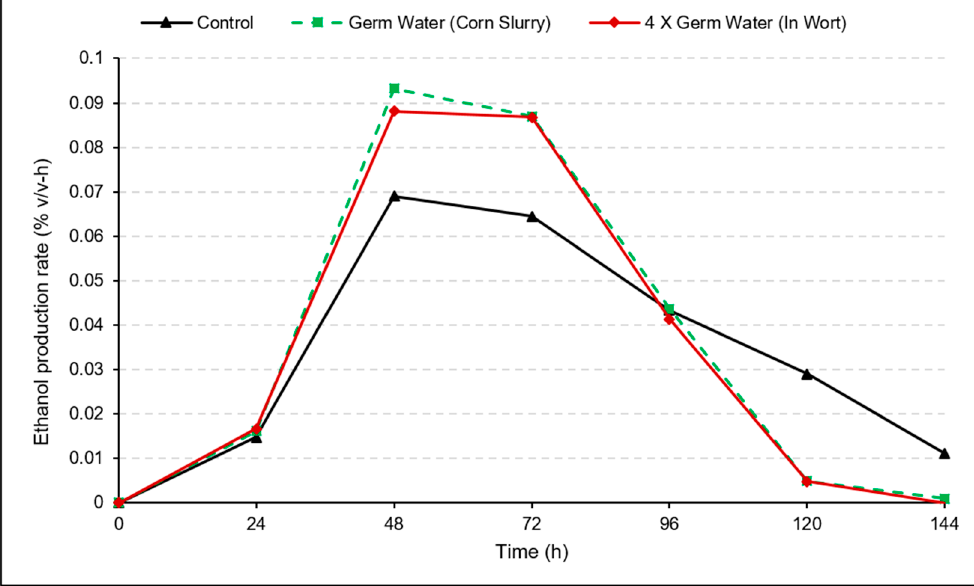
Figure 6. Rate of ethanol production during fermentation for three cases: (i) control, (ii) use of germ soak water in corn mash, (iii) use of concentrated germ soak water in wort. Data in the graphs is the average of two replications.